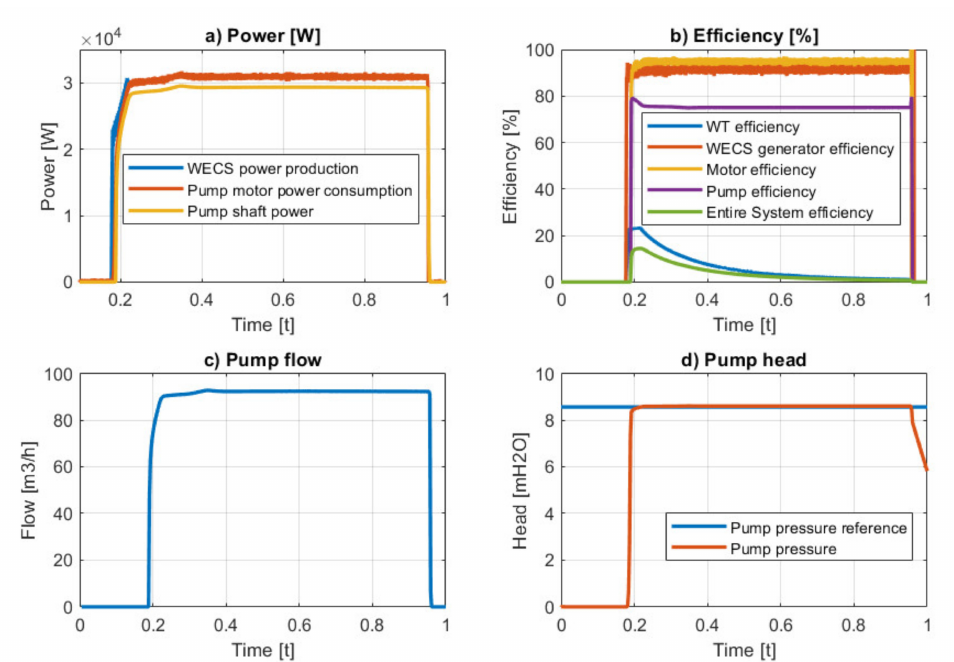
Figure 7. Simulation results: ( a ) WECS power production and PS power consumption; ( b ) efficiency of each subsystem in the PS powered by the WECS; ( c ) pump flow; ( d ) pump head including its